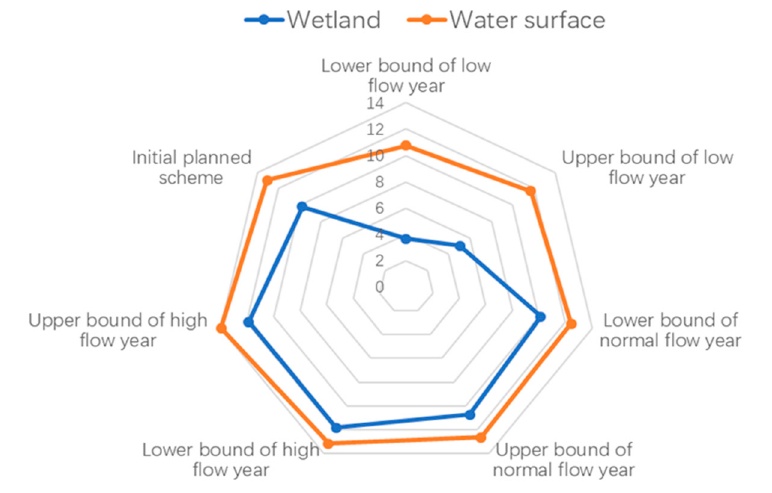
Figure 3. Restored area of wetland and water surface in different scenarios.